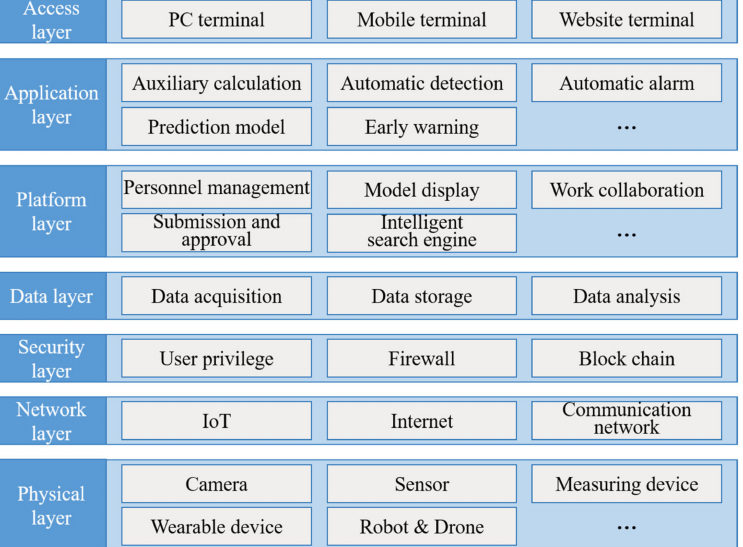
Figure 6. Framework of enterprises at level 4.